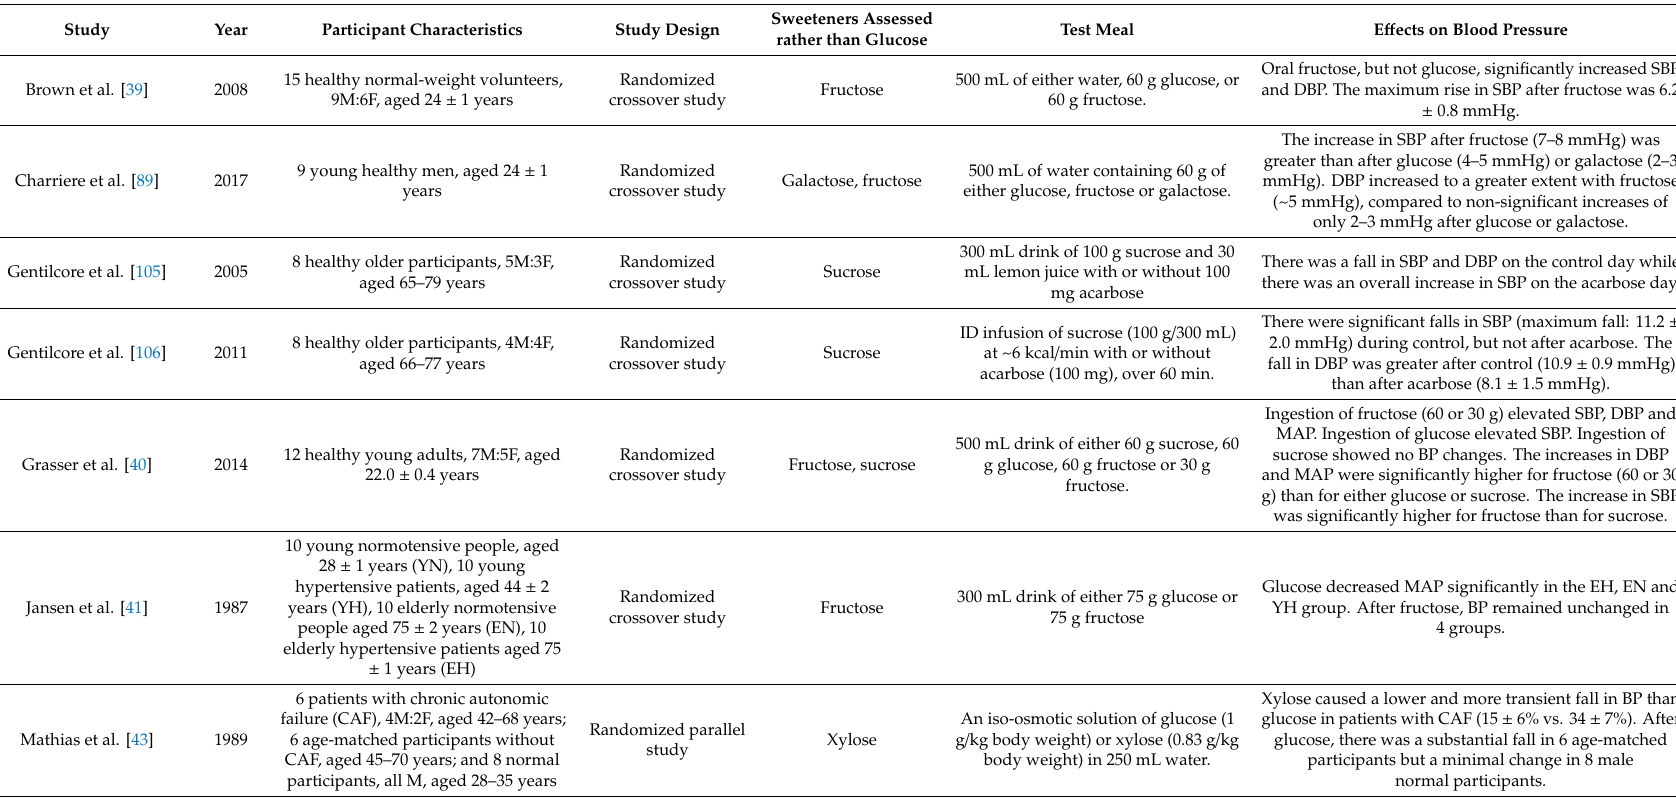
Table 2. Studies relating to the e ff ects of other nutritive sweeteners on blood